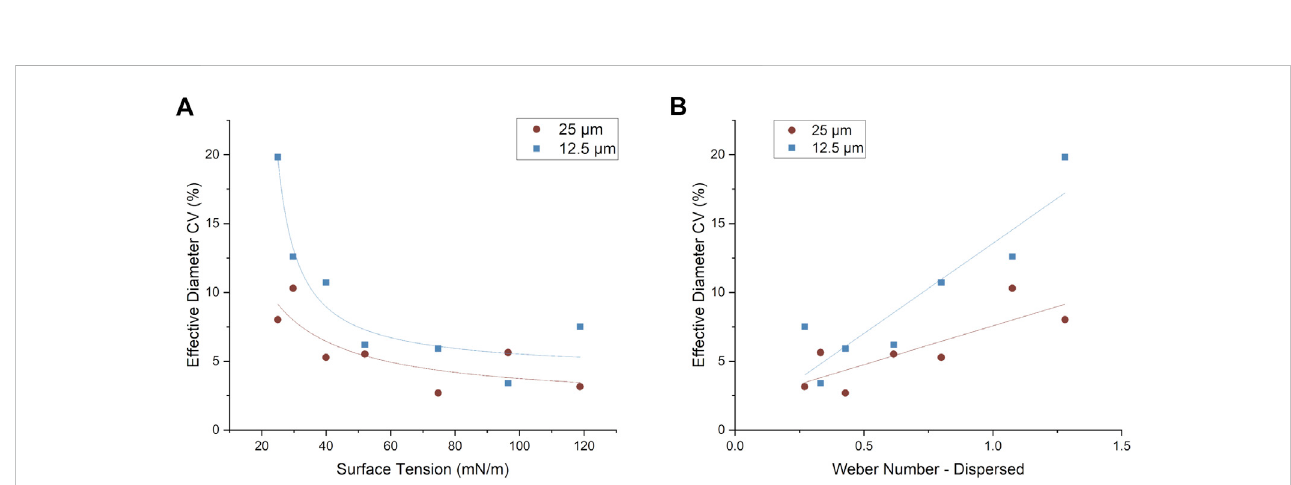
FIGURE 6 Droplet diameter CV plotted as afunction of (A) surfacetension and (B) Weber number ofthedispersedphase (We d )for the12.5and 25